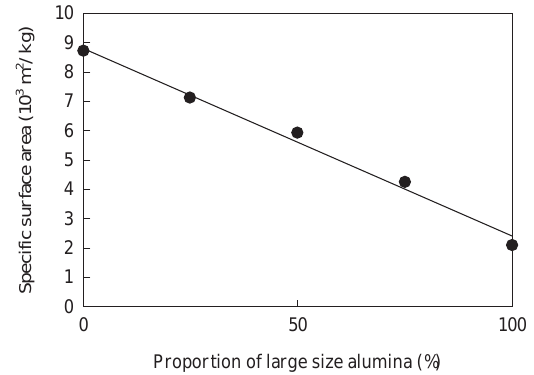
Fig. 9 illustrates the relation between the proportion of large size alumina particles and the porosity of the alumina particle layer. Fig. 9 reveals that when the proportion of large size alumina particles is 25%, the porosity is minimized and when the proportion of large size alumina particles exceeds 25%, it increases. Fig. 10 shows the pore size distribution curves of the particle size blended powder samples. When the pro- portion of large size particles is 0% (A), a sharp peak is present at an R of 0.05 µ m. When the proportion of P large size particles is 25% (B), a peak occurs at R of P 0.06 µ m, meaning a slight shift in this peak. When the proportion of large size particles is 50% (C), two peaks are present on the pore size distribution curve; namely one at 0.06 µ m and the other at 0.1 µ m. When the proportion of large size particles is 75% (D), there is no peak at 0.06 µ m while peaks are present at 0.1 and 0.20 µ m. The latter peak, at 0.20 µ m, is also pre-